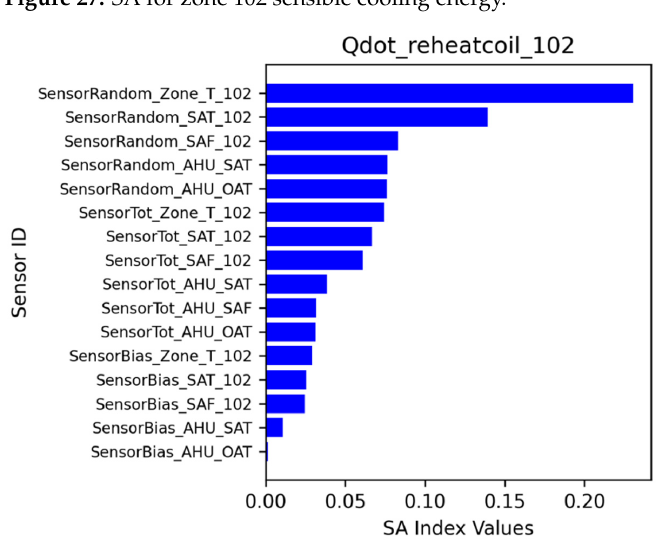
Figure 28. SA for zone 102 reheat coil energy.